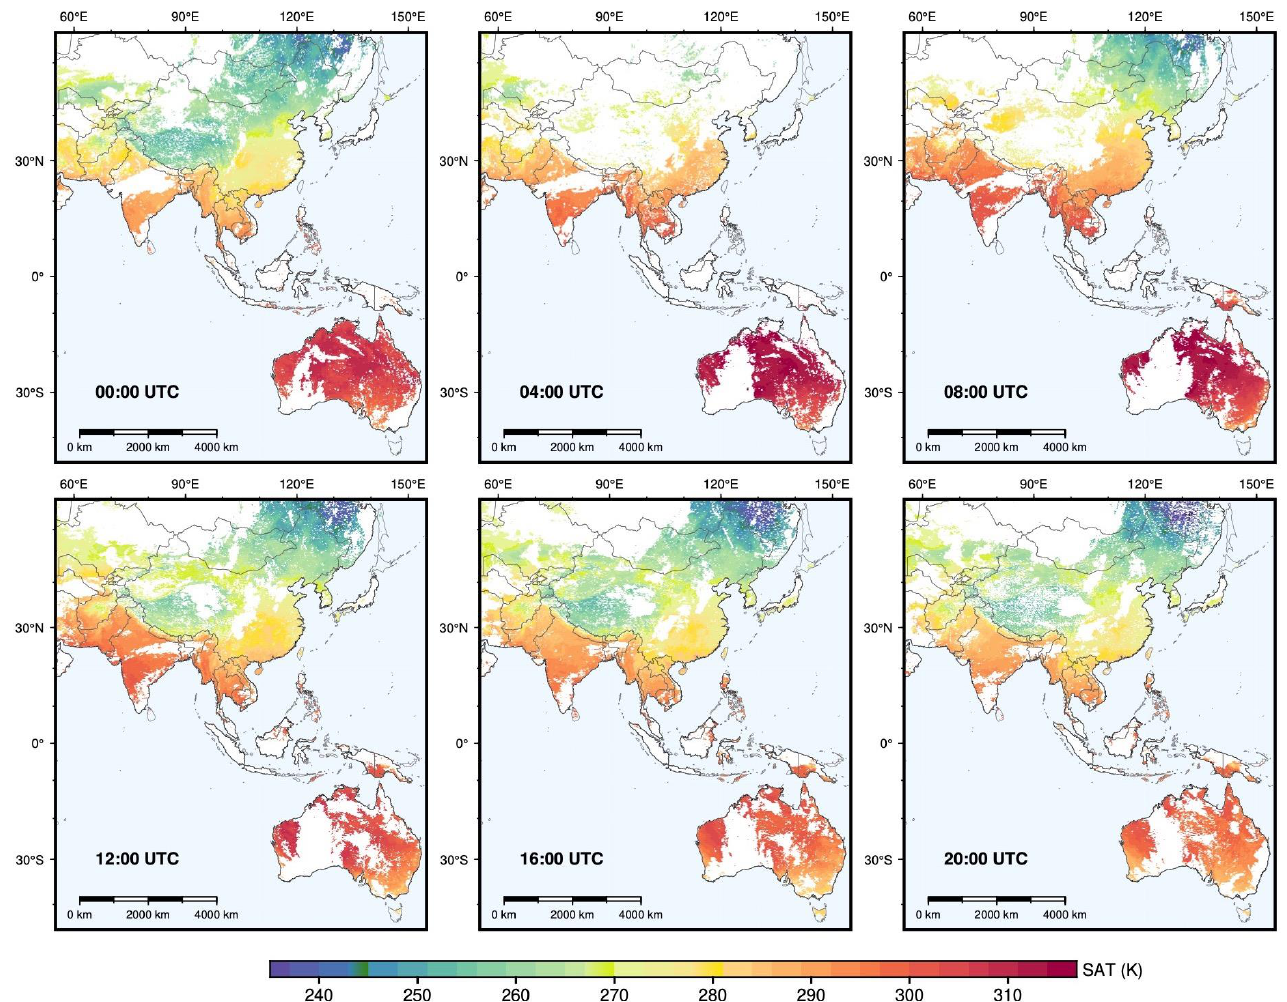
Figure 9. Examples of estimated SAT for six hour-points of the day with the highest daily coverage throughout the study period.